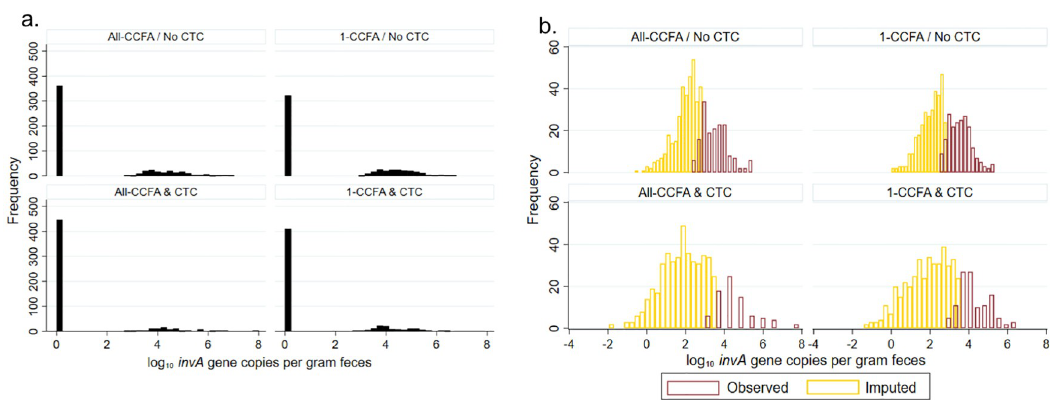
Fig 4. Distribution of log 10 invA gene copies per gram feces per treatments before (a) and after imputation (b). Missing raw count below the limit of quantification were given a value of 1, which are shown as 0 following log 10 transformation (a). CCFA: ceftiofur crystalline-free acid, CTC: chlortetracycline.